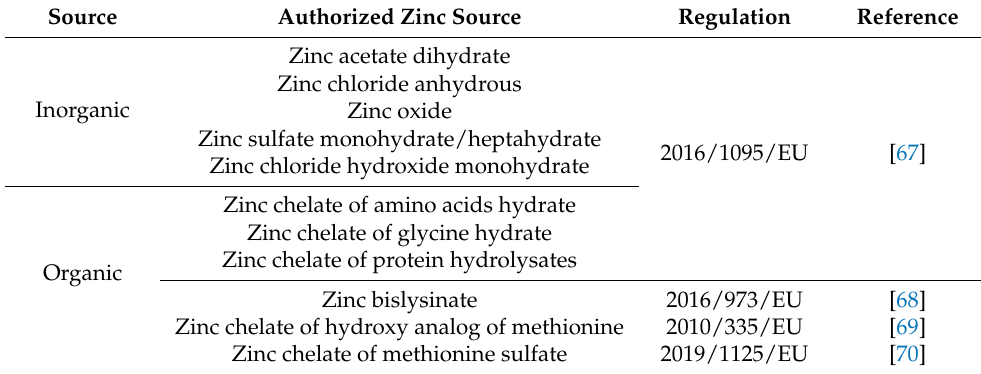
Zinc sources authorized as additives for animal feed supplementation in the European